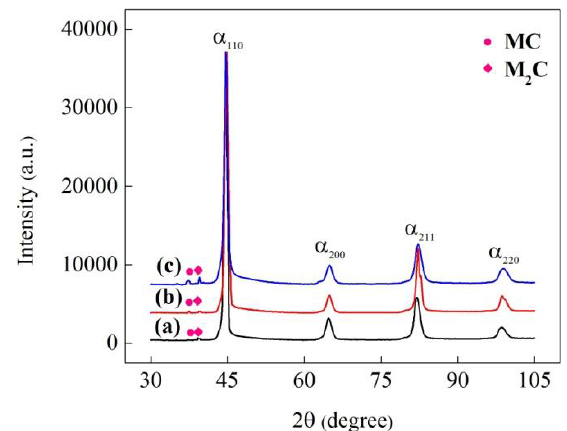
Figure 7. X-ray di ff raction patterns of tempered specimens: ( a ) Q-T process and austempering process ( b ) without and ( c ) with CR.